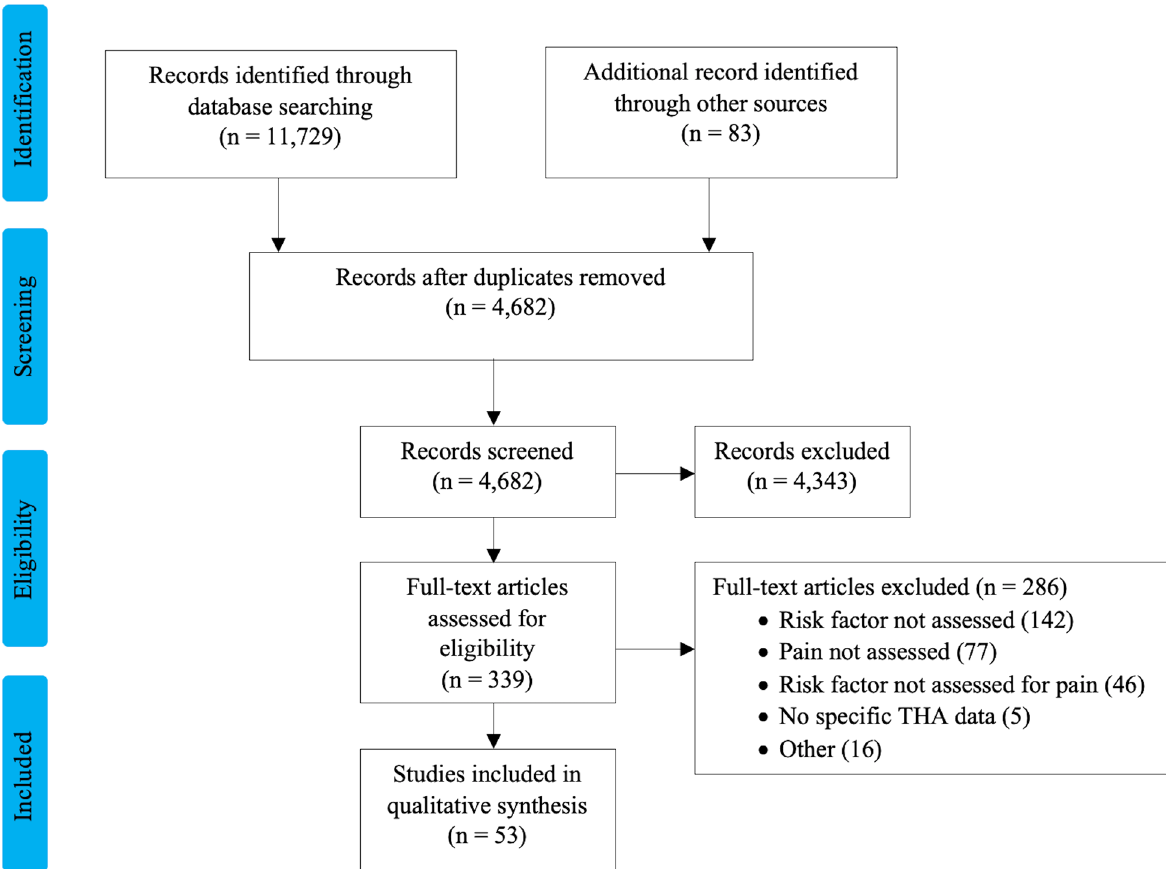
Fig. 1 Flow diagram of a systematic review of articles published from January 1995 to May 2018 about adults undergoing total hip arthroplasty. The databases searched were PubMed (Medline), Scopus, Web of Science, Cumulative Index of Nursing and Allied Health Literature Plus (EBSCO), Embase, and